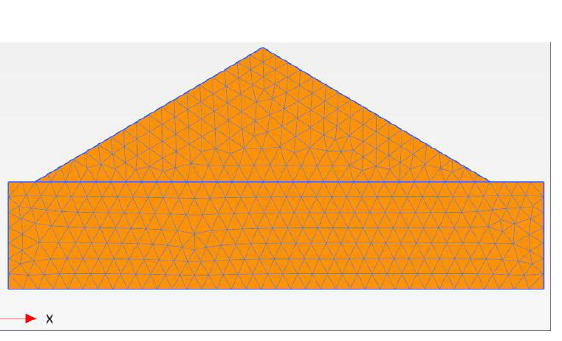
Figure 9: Geometric model of a complete flood embankment model (type 2 model) designed in the Plaxis software. acquired in the triaxial shear test apparatus for a medium dense sample. The minimum value of cohesion (0.1 kPa) associated with the initial soil humidity was adopted for the calculations.